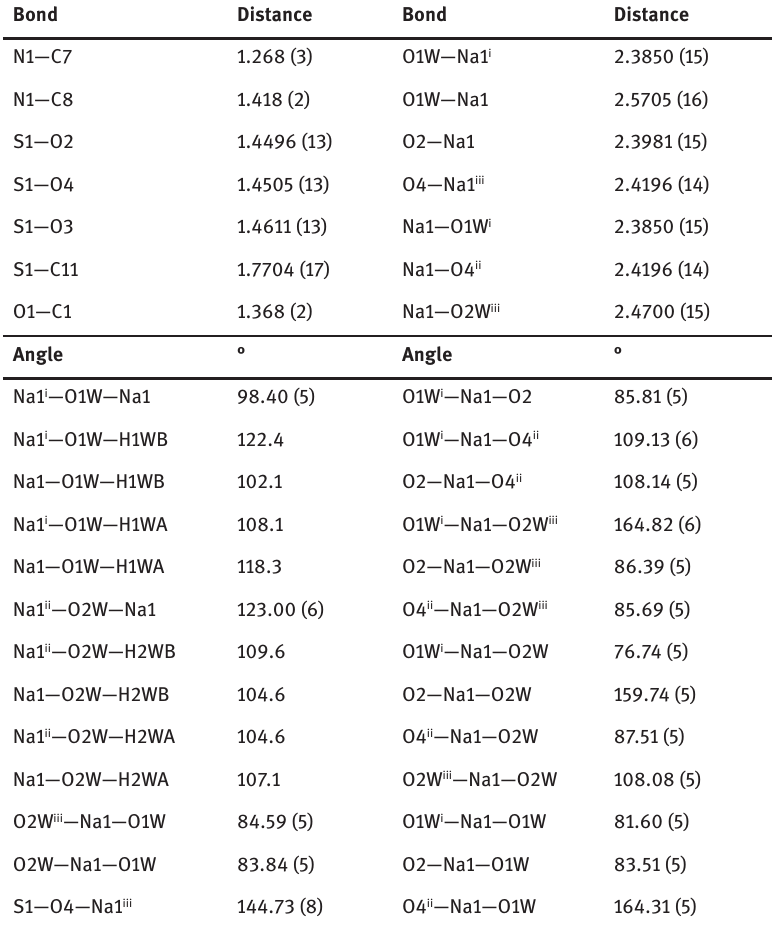
Table 2: Selected bond lengths (Å) and angles (°) for 1 . Bond Distance Bond